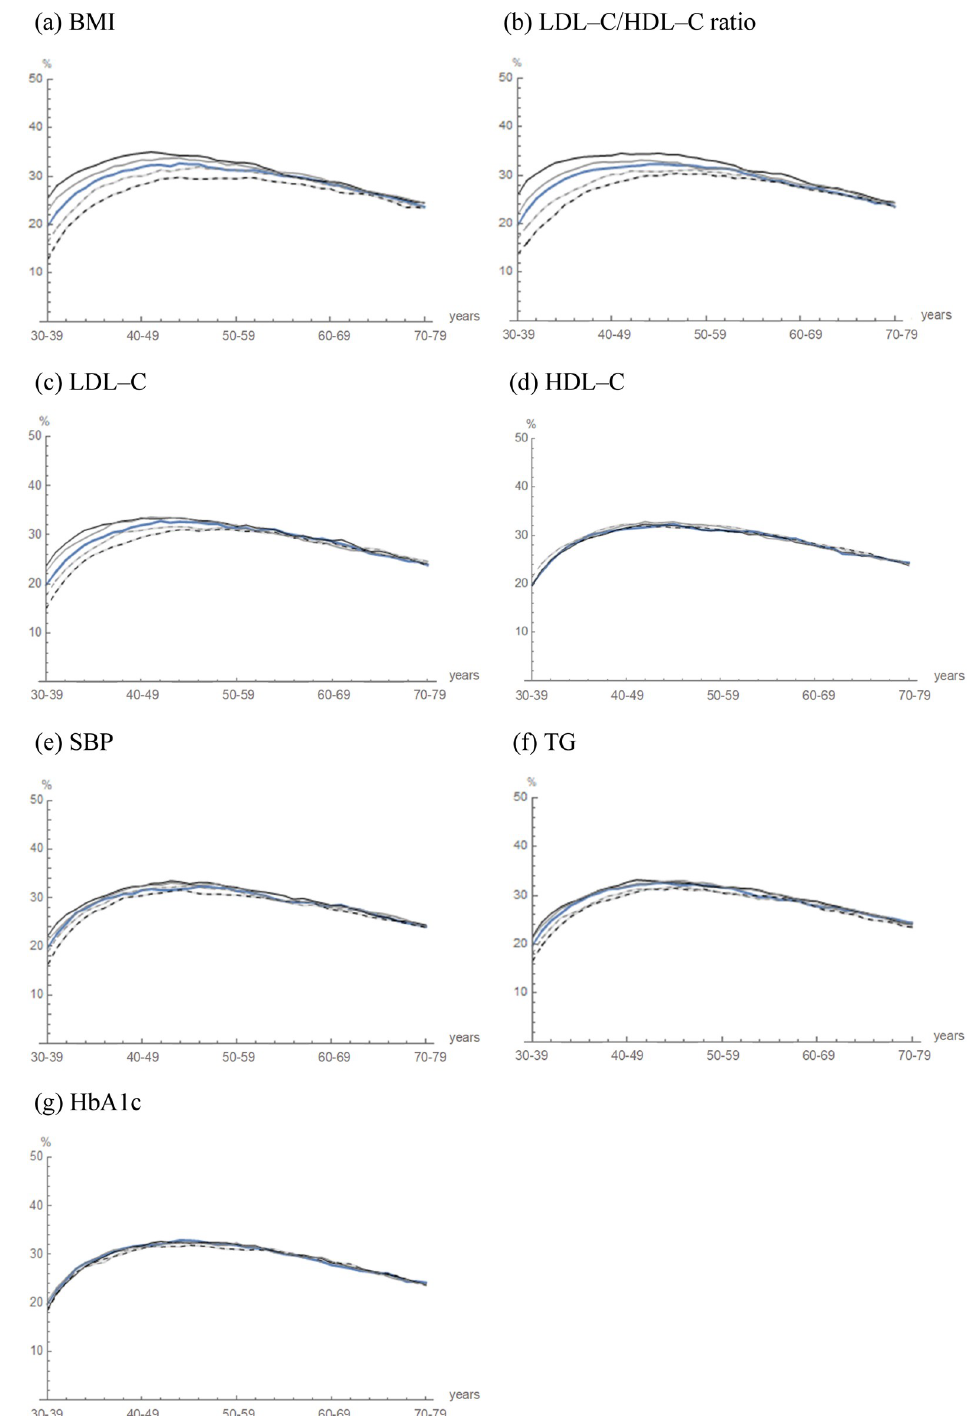
Fig 4. Projected prevalence of fatty liver with variations by changes in the clinical and biochemical predictor variables of cohort 2. The trajectories of the projected prevalence in cohort 2 (blue curve) are illustrated. The initial proportion of the clinical and biochemical predictor variables of cohort 2 were varied by − 40% (dashed black curve), − 20% (dashed gray curve), 20% (gray curve) and 40% (black